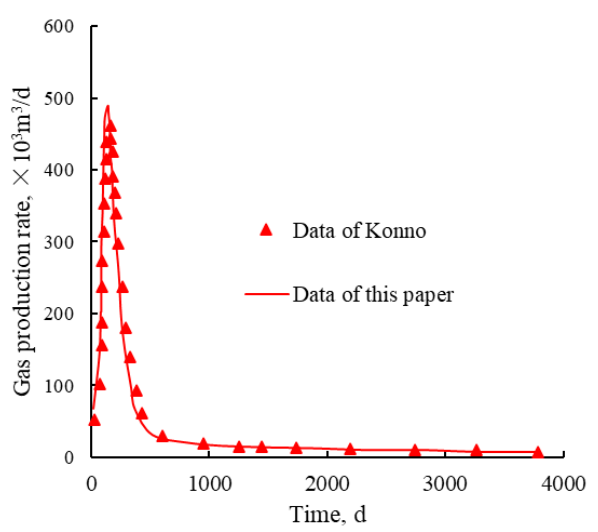
Figure 1. Comparison between Konno’s model and the model in this paper.